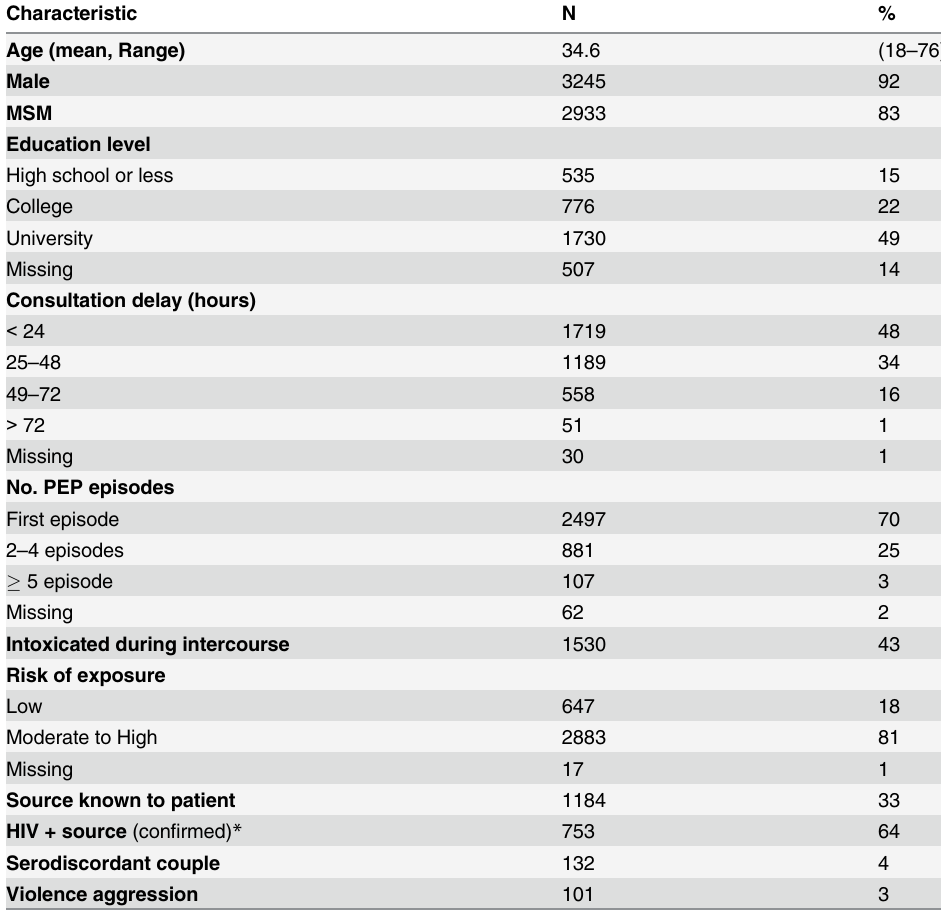
Table 1. Patient and exposure characteristics (N =